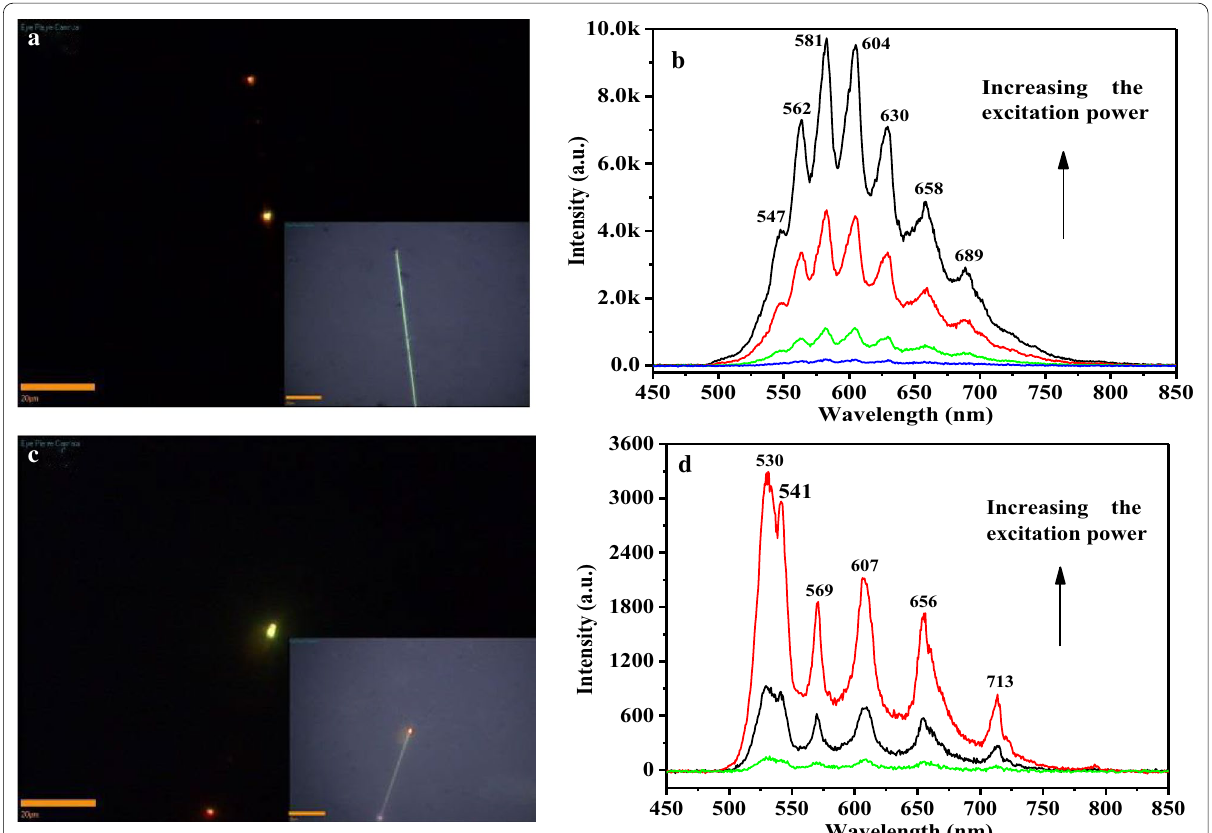
Fig. 6 a , c Far-field emission and optical (inset) images of CdS nanowires with higher dopant concentration. Scale bars is 20 μm; b , d The corresponding far-field PL